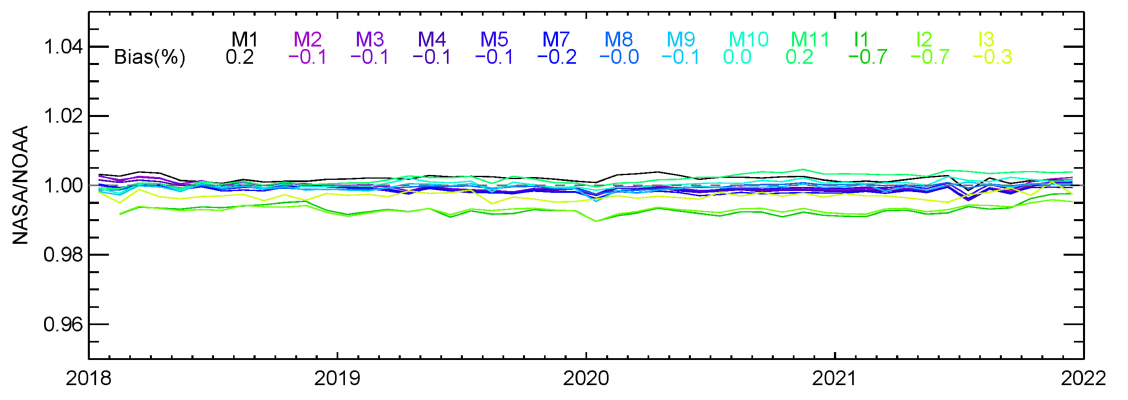
Figure 7. Monthly DCC ratio time series for the NASA-N20-C2 and NOAA-N20-ConstF